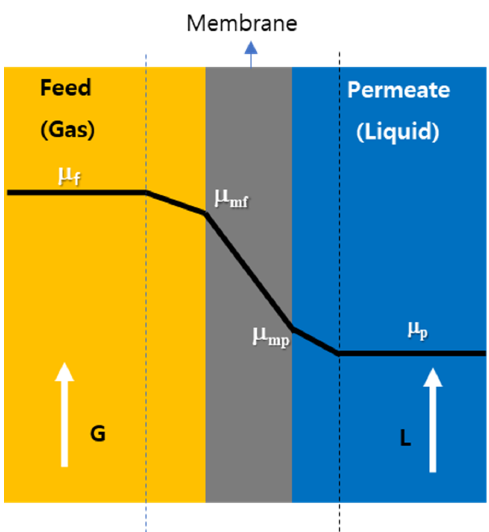
Figure 1. The schematic representation of the chemical potential profile of permeant across membrane system, G = gas flow rate, L = liquid flow rate, µ f , µ mf , µ mp , and µ p chemical potentials of permeant.